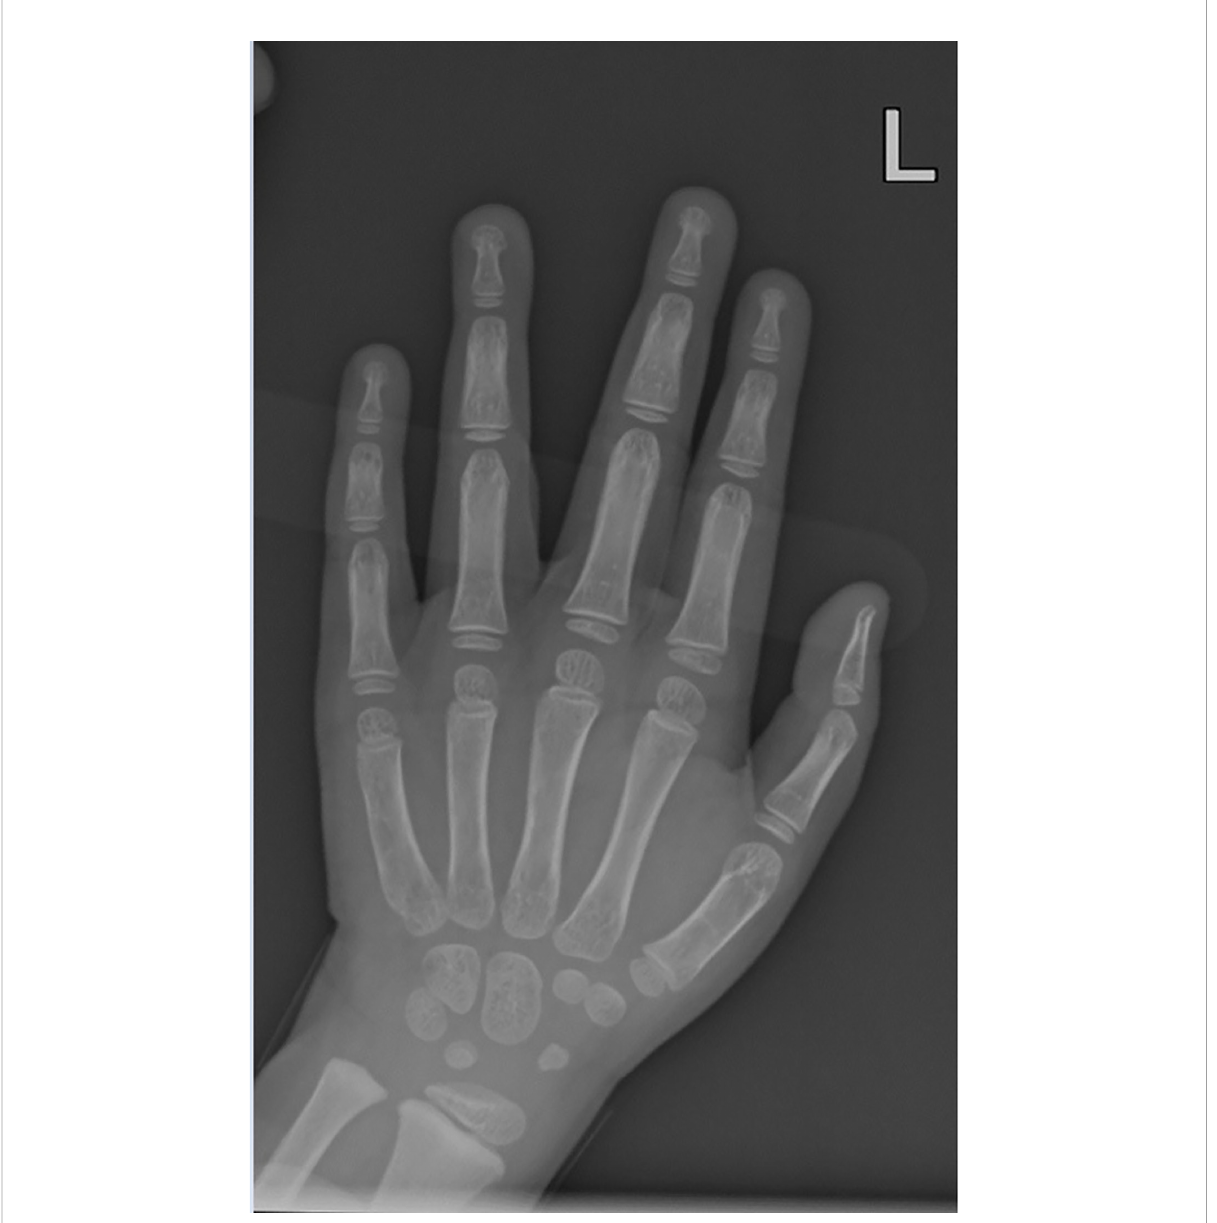
FIGURE 1 Bone age fi lm for case 1, female child. The carpal bones were noted to be closest to fi ve years while the phalangeal bones were found to be between four years and 2 months and fi ve years using the Greulich and Pyle method, at chronological age two years and 11